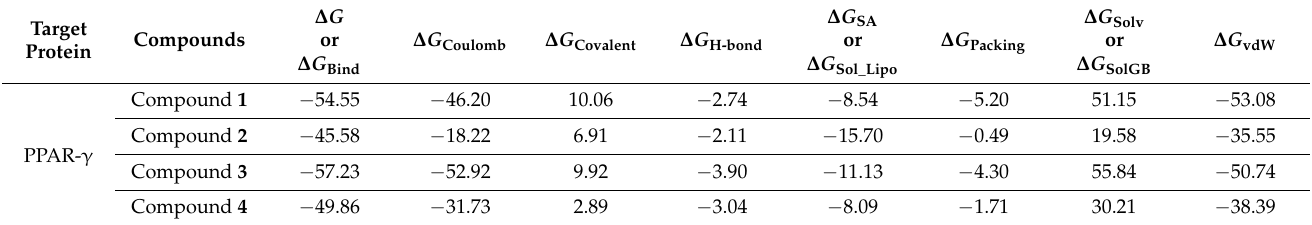
Table 6. Calculation of free energy (MM-GBSA) for the interactions between PPAR- γ and 5-HT 1A with the SI compounds ( 1 – 8